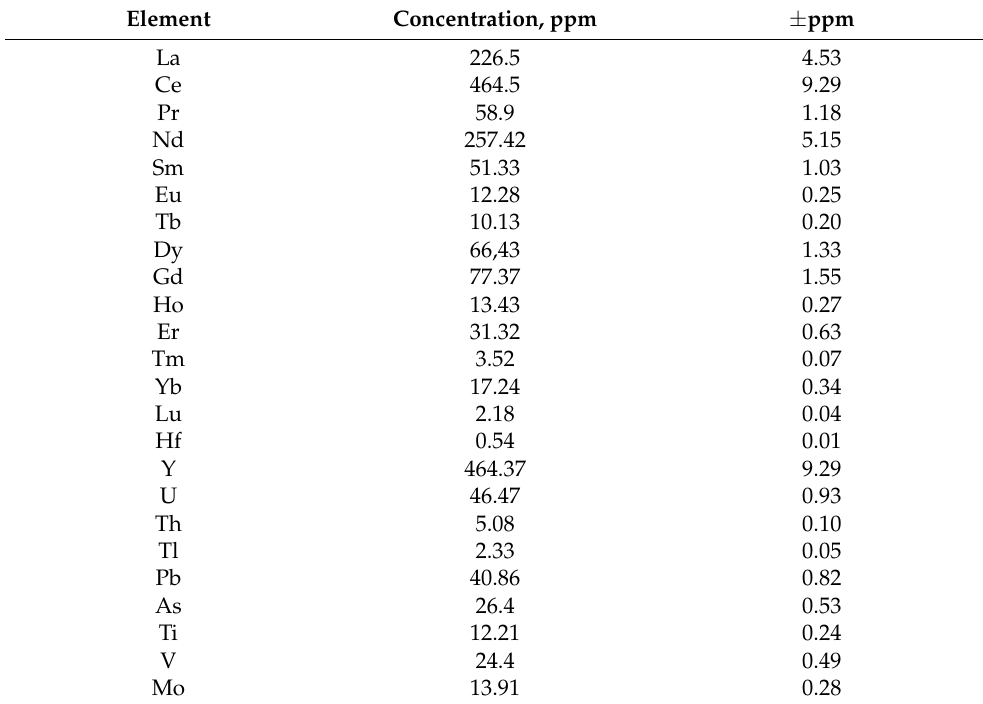
Table 2. Content of rare earths, some radioactive elements, toxic elements, and d-metals in con- centrated phosphorite ore. 2.46 g phosphorite ore powder was dissolved in 100 mL 7.5M HNO 3 . Dissolution was performed in a 200 mL plastic bottle for 1 h. Dissolution was performed at